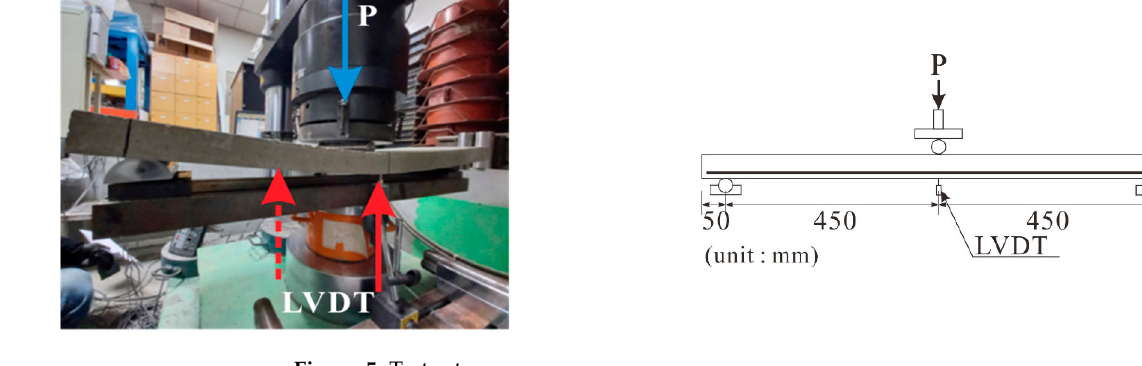
Figure 5. Test set-up.